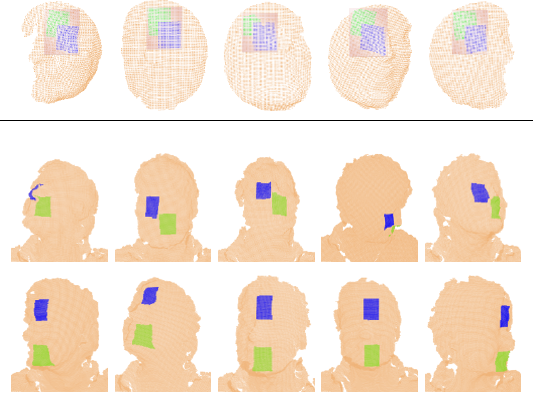
Fig. 4 Feature selection. Top: feature used in head pose estimation. Middle, bottom: two kinds of features used in facial landmark localization framework. Note that the latter features are well